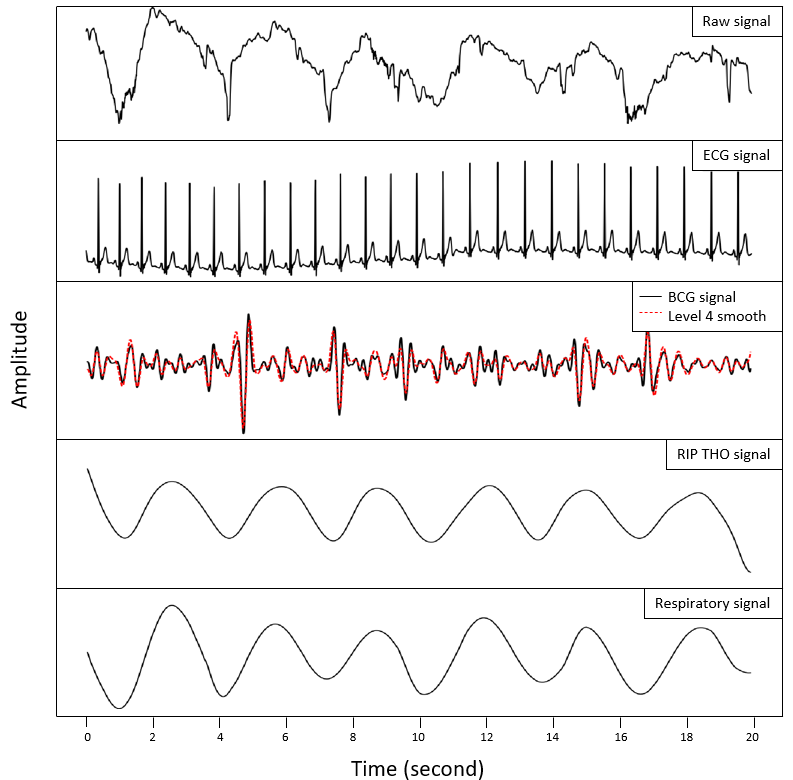
Figure 4. The label description of the figure from top to bottom are as follows: the acquired signal from the strip sensor under the thoracic region (Raw signal), the reference ECG signal as the gold standard (ECG signal), BCG signal and the processed signal acquired from the strip sensor for HR estimation (BCG signal and 4th smooth level), the reference respiration signal from the thoracic region as the gold standard (RIP THO signal), and the respiration signal from the strip sensor under the thoracic region (Respiration signal): 20 s of the 9th subject’s signals in P 4 position. The sensitivity of the FSR strip enabled us to detect the smallest movements caused by cardiac and breathing